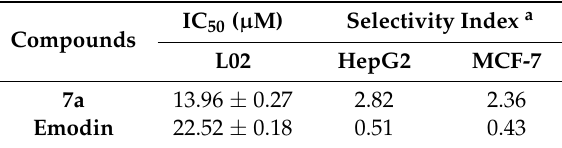
Table 5. In vitro anti-proliferative activities of compound 7a against normal cell line (L02).